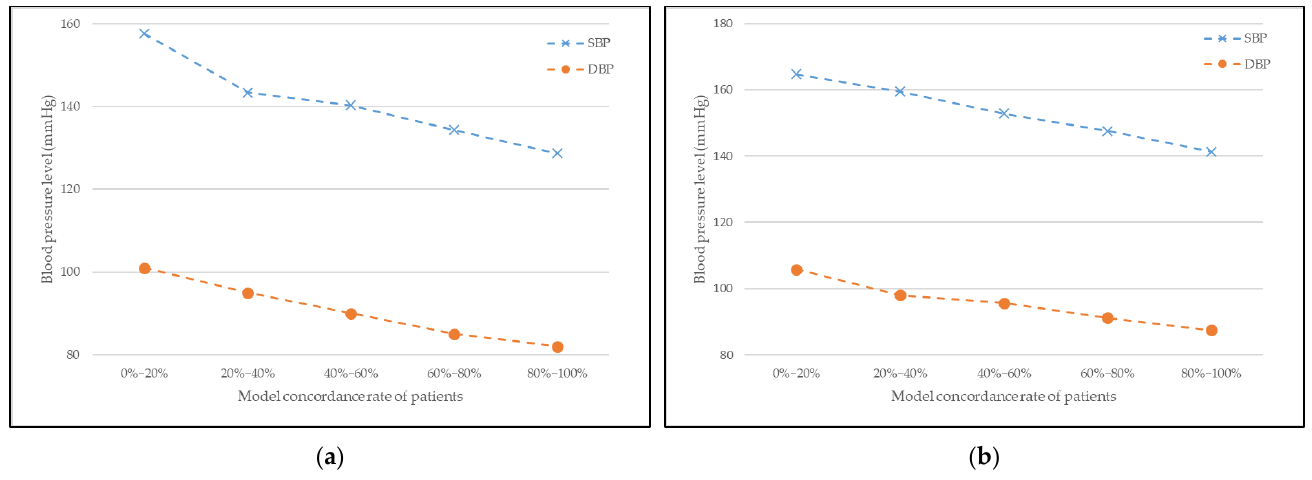
Figure 5. Relationship between patients’ model concordance rate and blood pressure level for ( a ) male patients and ( b ) female patients. Table 9. Concordance rate of Q-learning and MDP between model’s recommendation and doctor’s prescriptions.